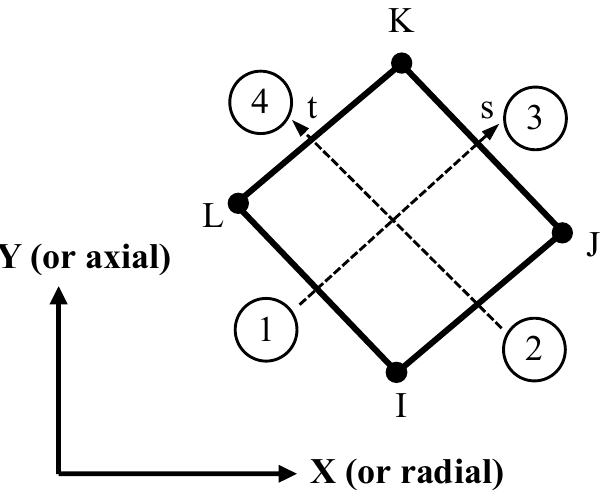
Figure 12. Characteristics of the PLANE55 element.